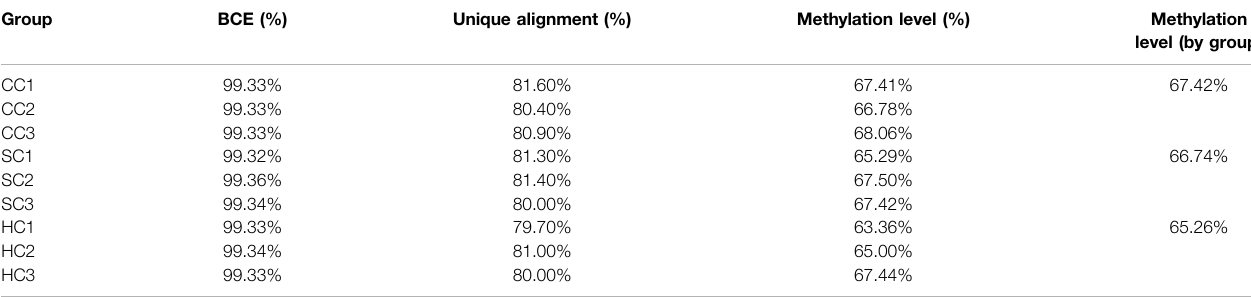
TABLE 1 | Basic state of alignment, bisul fi te conversion ef fi ciency, and methylation level. Group BCE (%) Unique alignment (%)